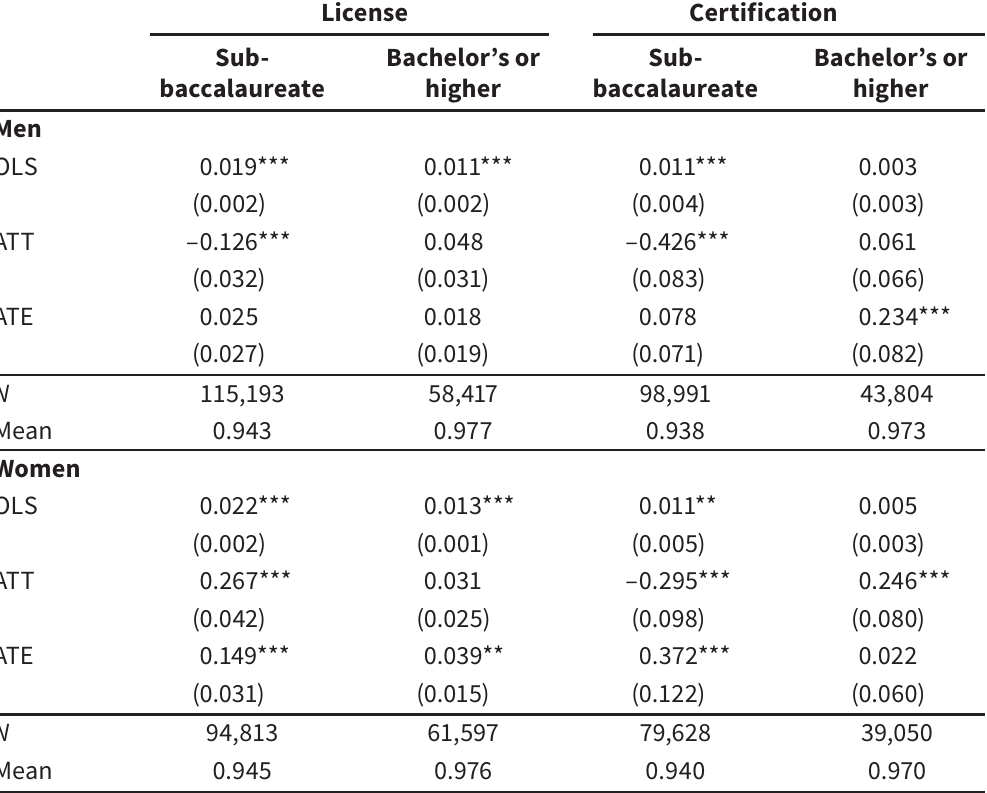
Effects of credential-holding on employment by gender and level of education License